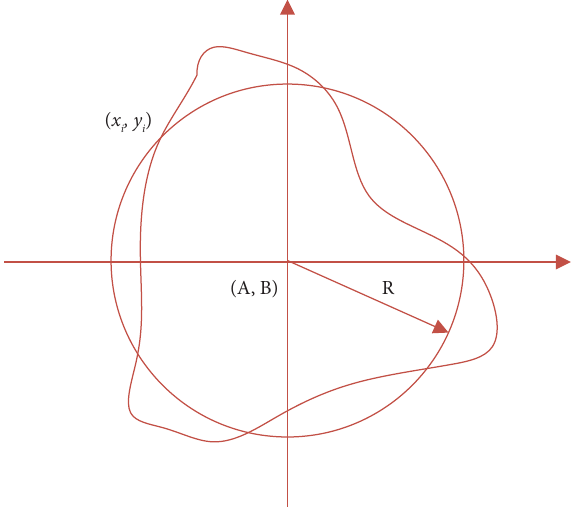
Figure 3: Least square ftting